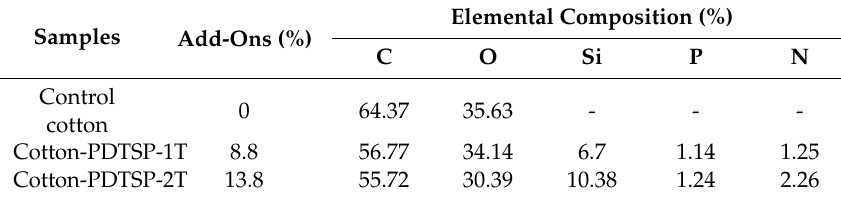
Table 1. Add-ons and elemental composition of PDTSP-coated cotton fabrics.